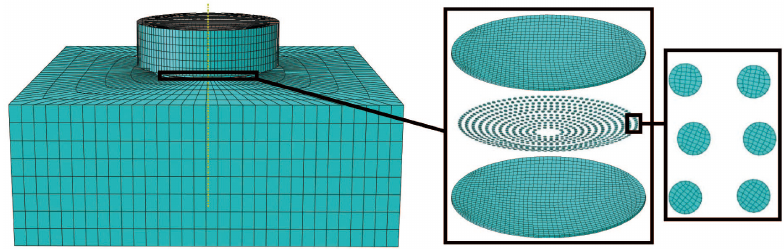
Figure 6. Finite Element Model of the rotating mechanism Note: the base is fixed during the simulation.